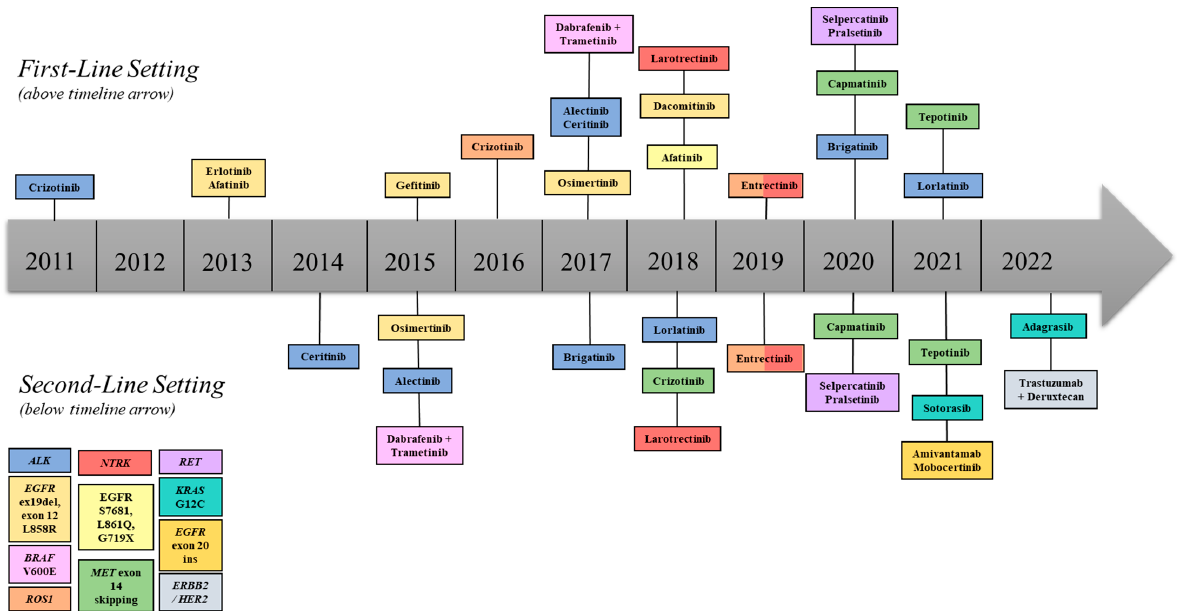
Figure 1. Timeline of FDA-approved targeted therapies for NSCLC. First-line therapies depicted above, and second-line therapies depicted below the central arrow.